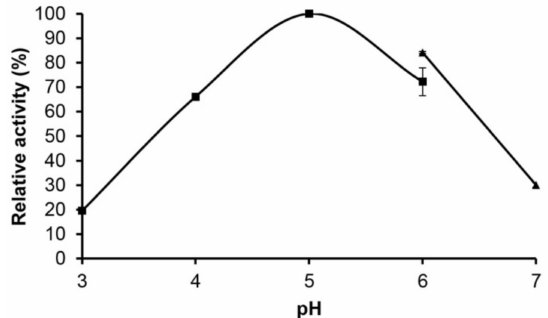
Figure 3. E ff ects of pH on the activity of purified Pc Xyn11A over a pH range of 3.0 to 7.0 under a standard enzyme assay condition. The bu ff ers used were 60 mM citric acid–sodium citrate bu ff er (pH